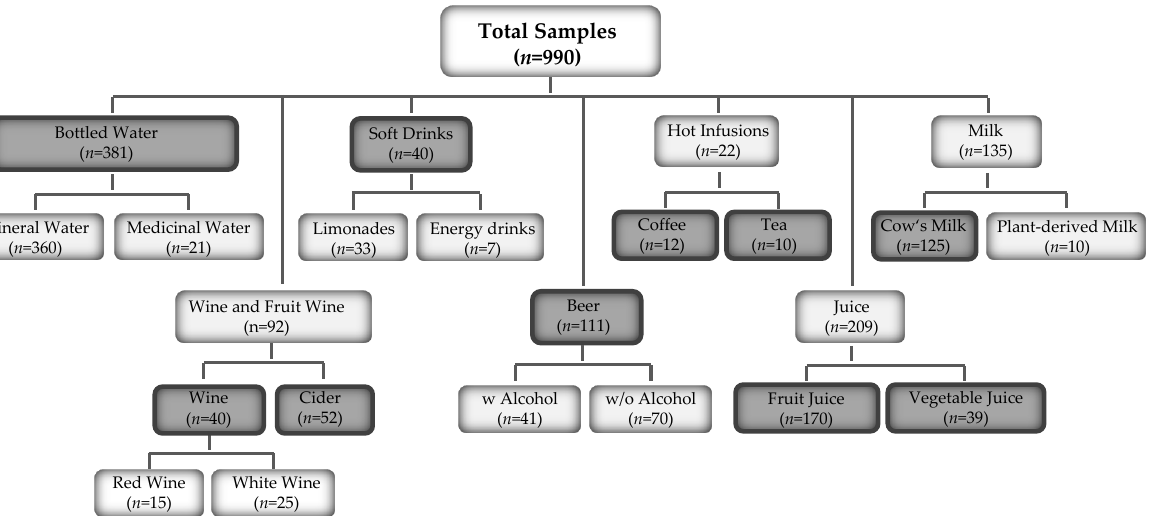
Figure 1. Overview of commercially available beverages in Germany that were included in this study ( n = 990). Samples were divided into 7 main and 15 sub-groups. Groups for further analysis of per capita consumption are shown in dark